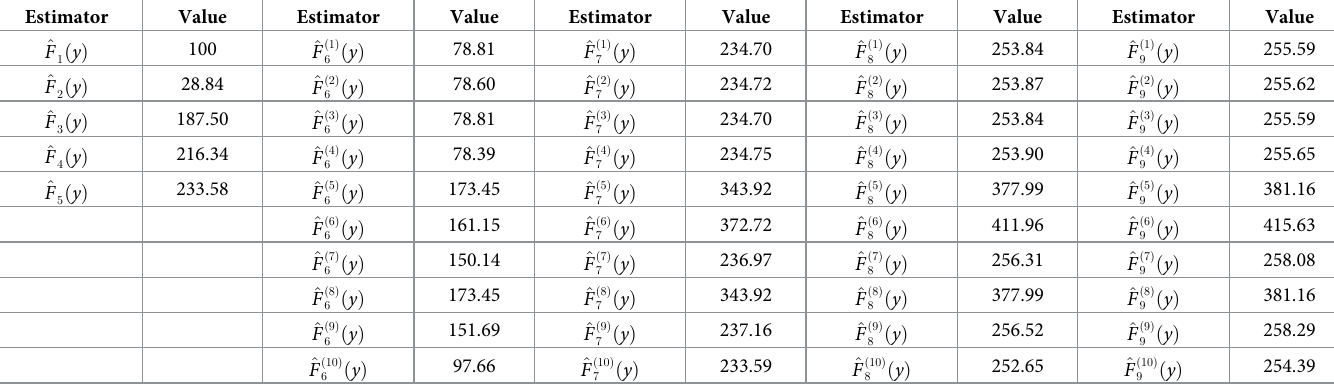
Table 3. PREs of distribution function estimators using Population I.